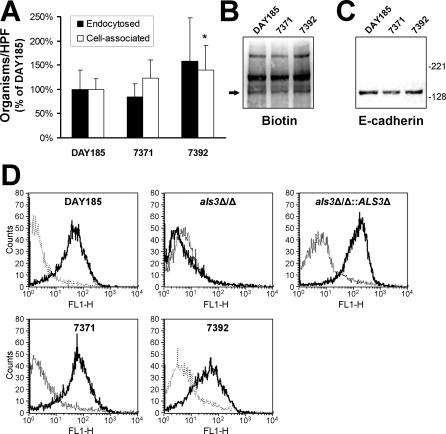
Endocytosis and E-Cadherin Binding of Different Strains of C. albicans
(A) Number of hyphae of the indicated clinical isolates of C. albicans that were endocytosed by and cell-associated with the FaDu oral epithelial cell line after a 45-min incubation. The data are expressed as a percentage of the results with strain DAY185, and are the mean ± SD of three experiments, each performed in triplicate. *, p < 0.05 compared to strain DAY185.(B and C) Immunoblot of biotinylated FaDu cell surface proteins eluted from the indicated strains of C. albicans. The same blot was probed with antibodies against biotin (B) or E-cadherin (C).(D) Flow cytometric detection of Als3 expression on the surface of C. albicans hyphae. Hyphae of the indicated strains were stained using indirect immunofluorescence with either a polyclonal rabbit anti-Als3 antiserum (solid lines) or purified rabbit IgG (broken lines) and then analyzed using flow cytometry.